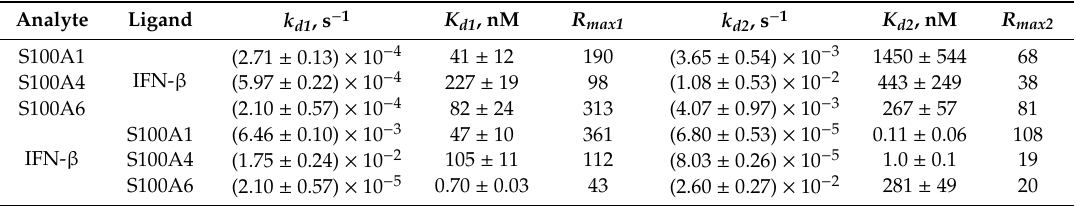
Table 1. Parameters of the heterogeneous ligand model [1] describing the SPR data on kinetics of the IFN- β —S100 interactions (Figures 1 and 2). R max refers to maximum response values. The standard deviations are